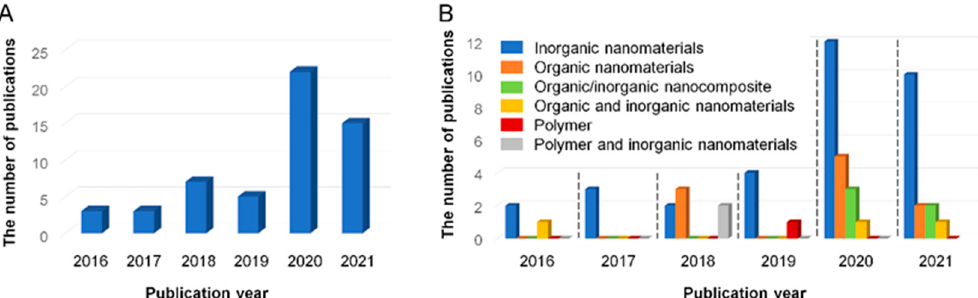
Figure 1. ( A ) The number of publications of research papers related to MMMs for pollutant removal. ( B ) The number of publications of research papers related to MMMs prepared with different types of additives for pollutant removal. The numbers of publications in 2021 in Figure 1A,B were obtained from the literature survey performed until the first quarter of 2021. The data in Figure 1 were obtained from the ScienceDirect database on 20 May 2021.